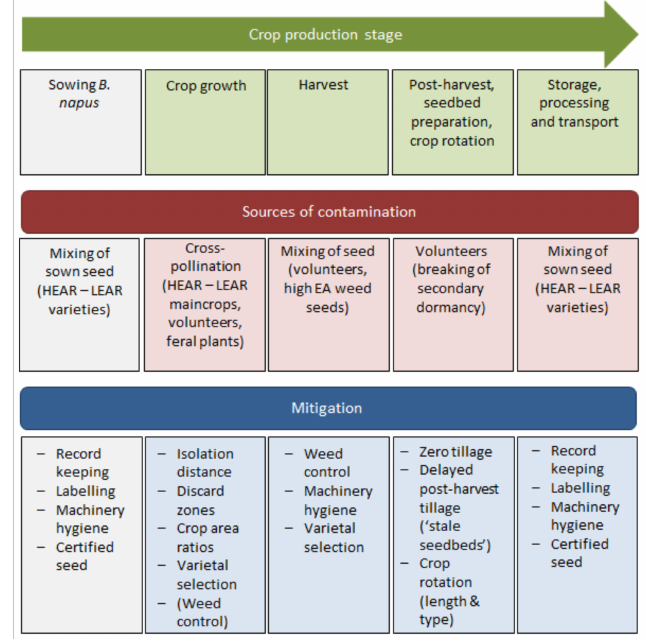
Figure 1. Critical control points for avoiding adventitious mixing (adapted from